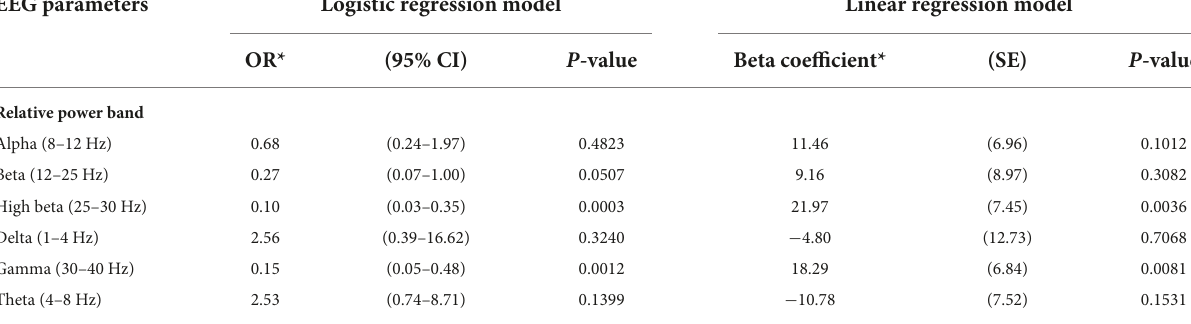
TABLE 2 Results from the logistic and linear regression models: OR (95% CI) for MCI and beta coefficients (SE) for SNSB-C score percentile, associated with EEG parameters in relative power. EEG parameters Logistic regression model Linear regression